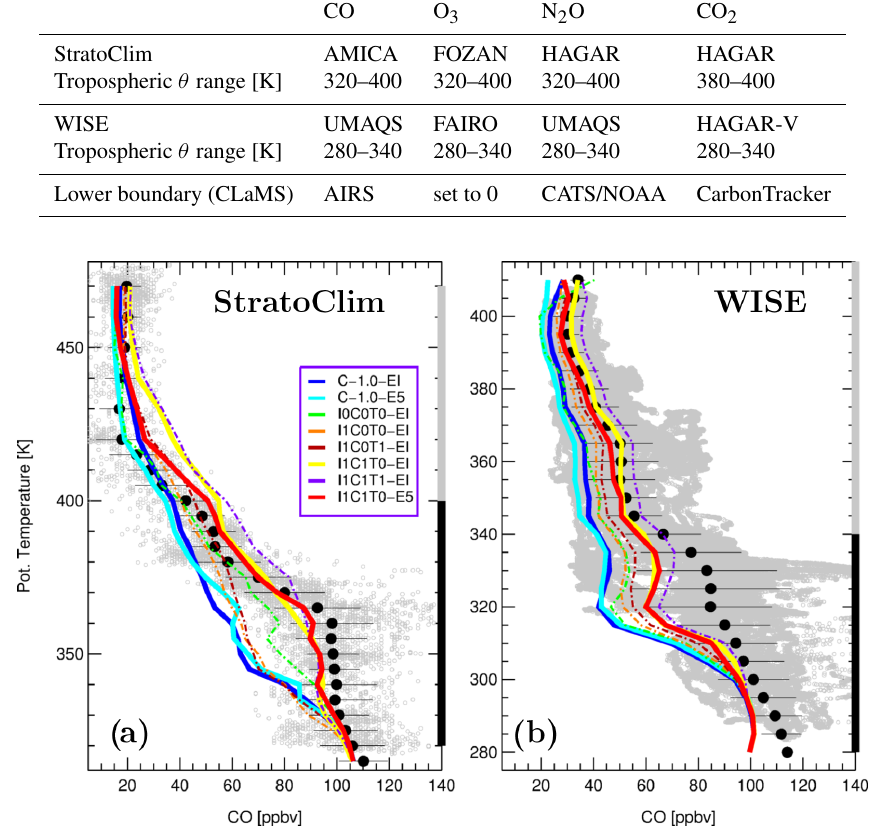
Figure 4. All CO observations (gray) during the StratoClim (a) and WISE (b) campaigns are shown versus CLaMS simulations. The averaged experimental data are plotted as black bold symbols (mean values are calculated by gridding all observations and using an overlapping boxcar width). The respective results for the model runs are color-coded as described in the legend. For the baseline runs (C-1.0) and for the best runs (I1C1T0) thick solid lines are used. The root mean square differences calculated between the simulations and experimental data in the tropospheric range (black solid line on the right y axis) are listed in Table 4. The performance in the stratospheric range (gray solid line on the right y axis) is discussed in Sect. 3.6. Note the different y axis ranges in (a) and (b)